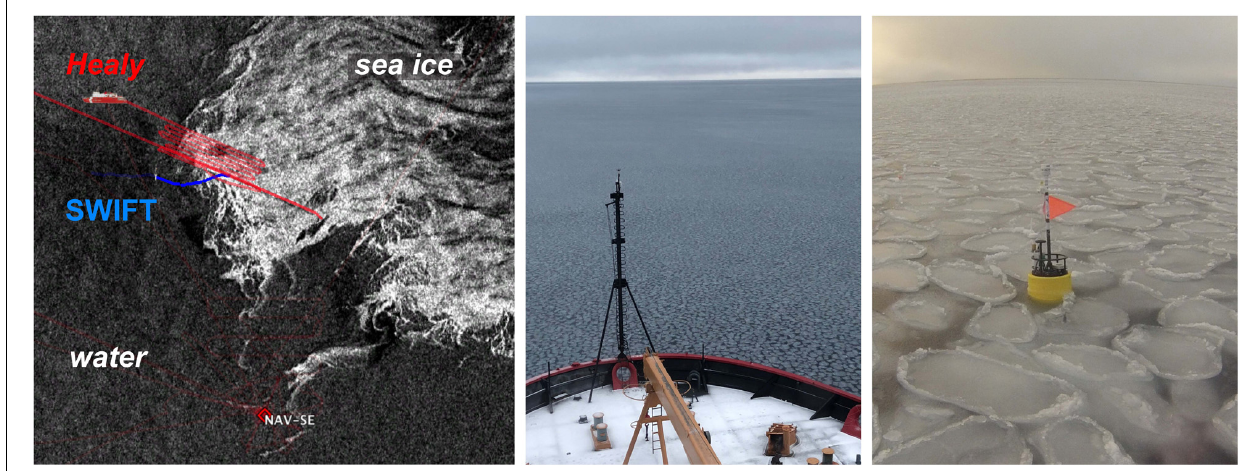
FIGURE 8 | (Left) 100 km square RS2 image (201810120308_RS2_SCWA) with 100 m resolution centered in a new ice formation region on 12 October. Location of the ship (red) and SWIFT buoy (blue) at the time of the image are indicated by their respective icons, with a 24 h track. (Center) Photograph of the pancake ice near the time of the image. After 12 h (Right) , pancakes were about 1 m in their longest dimension and 6 cm thick. The SWIFT buoy is pictured on the right.